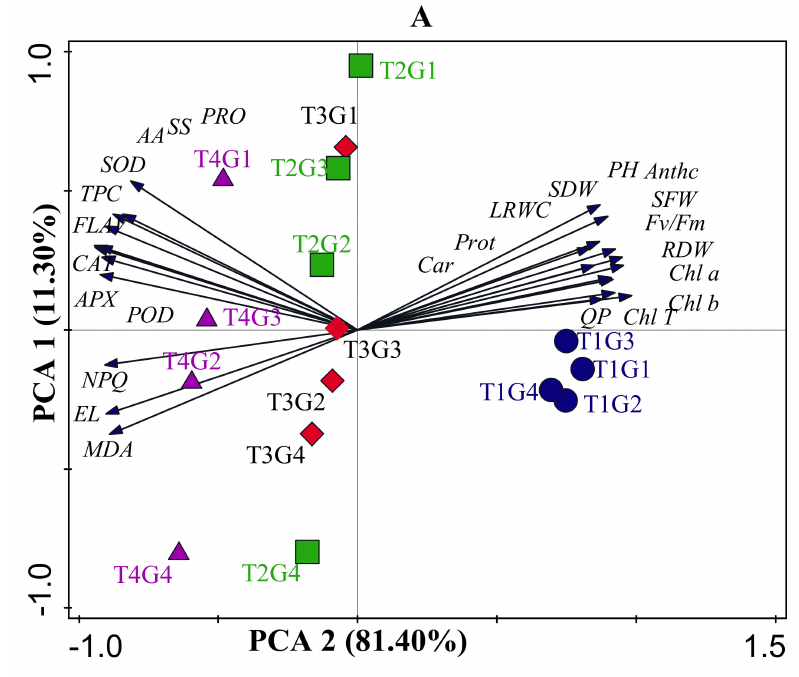
Figure 8. ( A ) Superoxide dismutase, ( B ) peroxidase, ( C ) catalase, and ( D ) ascorbate peroxidase activity levels of four soybean cultivars grown under drought and salinity stress conditions. Data presented are means ± SD, and different letters denote a significant difference at p < 0.05 based on the least significant difference (LSD) test. Letter a is highly significant than b, and ab means no significant differences between a with ab and b with